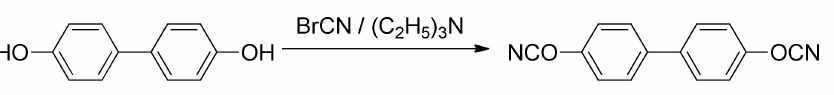
Figure 1. Scheme of synthesis of target dicyanate